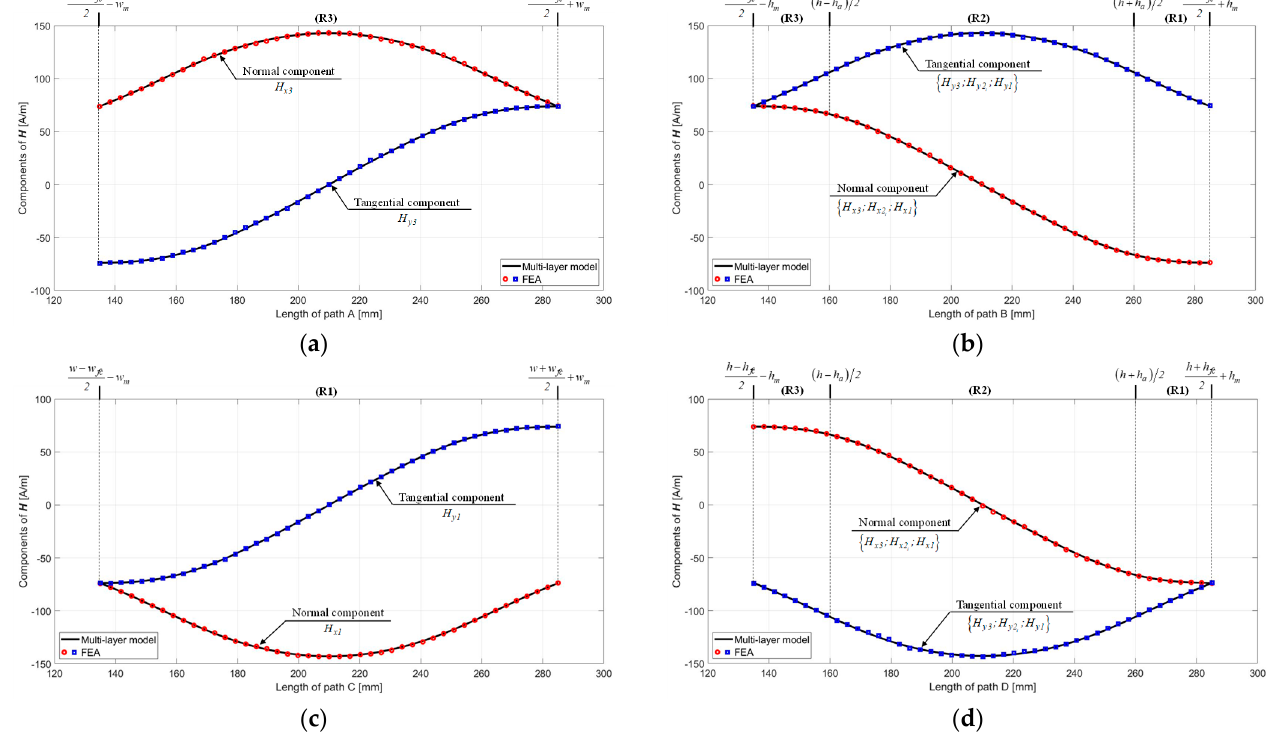
Figure 11. Components of H for a healthy FC calculated by the 2D multi-layer model and verified by 2D FEA on the path: ( a ) A, ( b ) B, ( c ) C and ( d ) D.